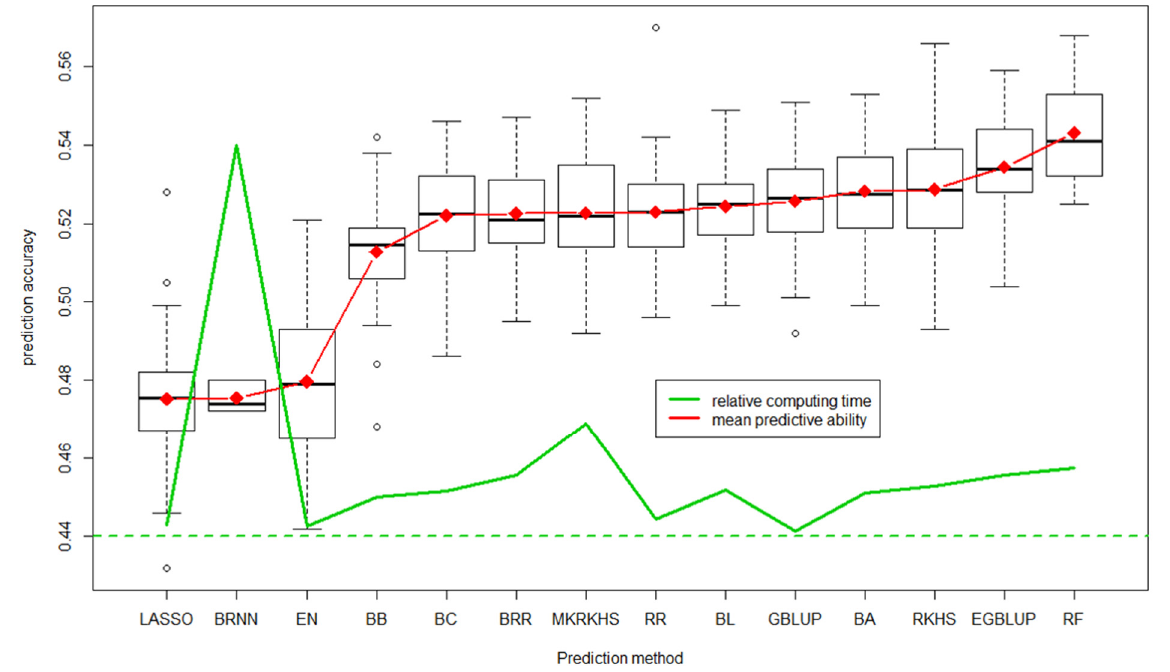
Figure 6. Distribution of predictive ability of the 100 replicates for each of the 14 methods ordered based on average predictive accuracy [120]. Average is shown in red and relative computing time in green. LASSO: least absolute shrinkage and selection operator, BRNN: Bayesian regularization for feed-forward neural network, EN: elastic net, BB: Bayes B, BC: Bayes C, BRR: Bayesian ridge regression, MRKHS: multiple RKHS, RR: ridge regression, BL: Bayesian LASSO, GBLUP: genomic best linear unbiased prediction, BA: Bayes A, RKHS: reproductive Kernel Hilbert space, EGBLUP: epistatic GBLUP, RF: random forest. The box are interquartile limits, dashed traits the 95% distribution and ◦ the outliers.